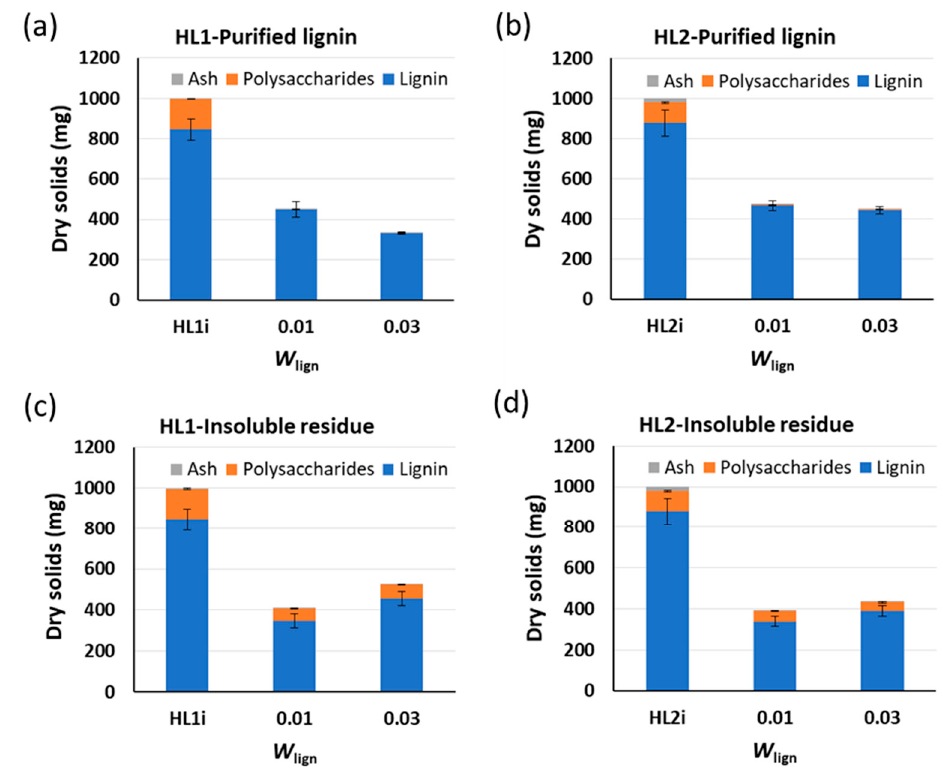
Figure 3. Influence of concentration of starting material (in weight %) in alkaline water on the composition of purified lignin (PL) for ( a ) HL1 and ( b ) HL2 lignins and insoluble residue (IR) for ( c ) HL1 and ( d ) HL2 lignins. Experiments are using 0.1 M NaOH and T = 25 °C. HL1i and HL2i represent the initial lignins before treatment. Standard deviation error bars of duplicate experiments.